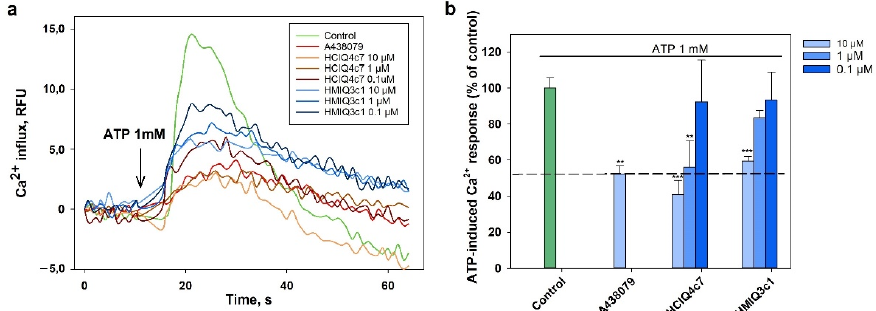
Figure 12. Influence of HCIQ4c7 and HMIQ3c1 on ATP-induced calcium influx in Neuro-2a cells. ( a ) Representative time course of [Ca 2+ ] I increases induced by ATP (1 mM) alone or in the presence of the peptides or the P2X7R blocker A438079 (10 µM) in Neuro-2a cells, as measured with Fluo-8.